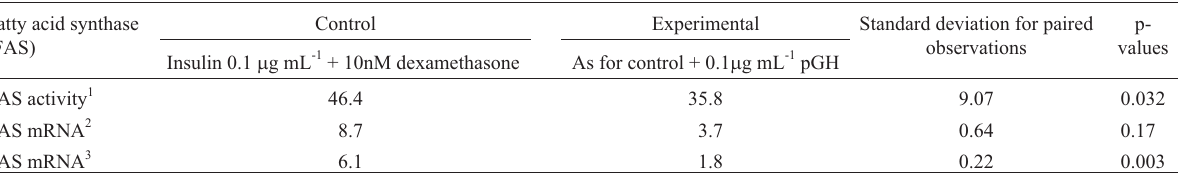
Table 1 - Effect of porcine growth hormone (pGH) on fatty acid synthase (FAS) activity and FAS mRNA concentration in swine adipose tissue cultured for 48 h. Fatty acid synthase Control Experimental Standard deviation for paired (FAS)